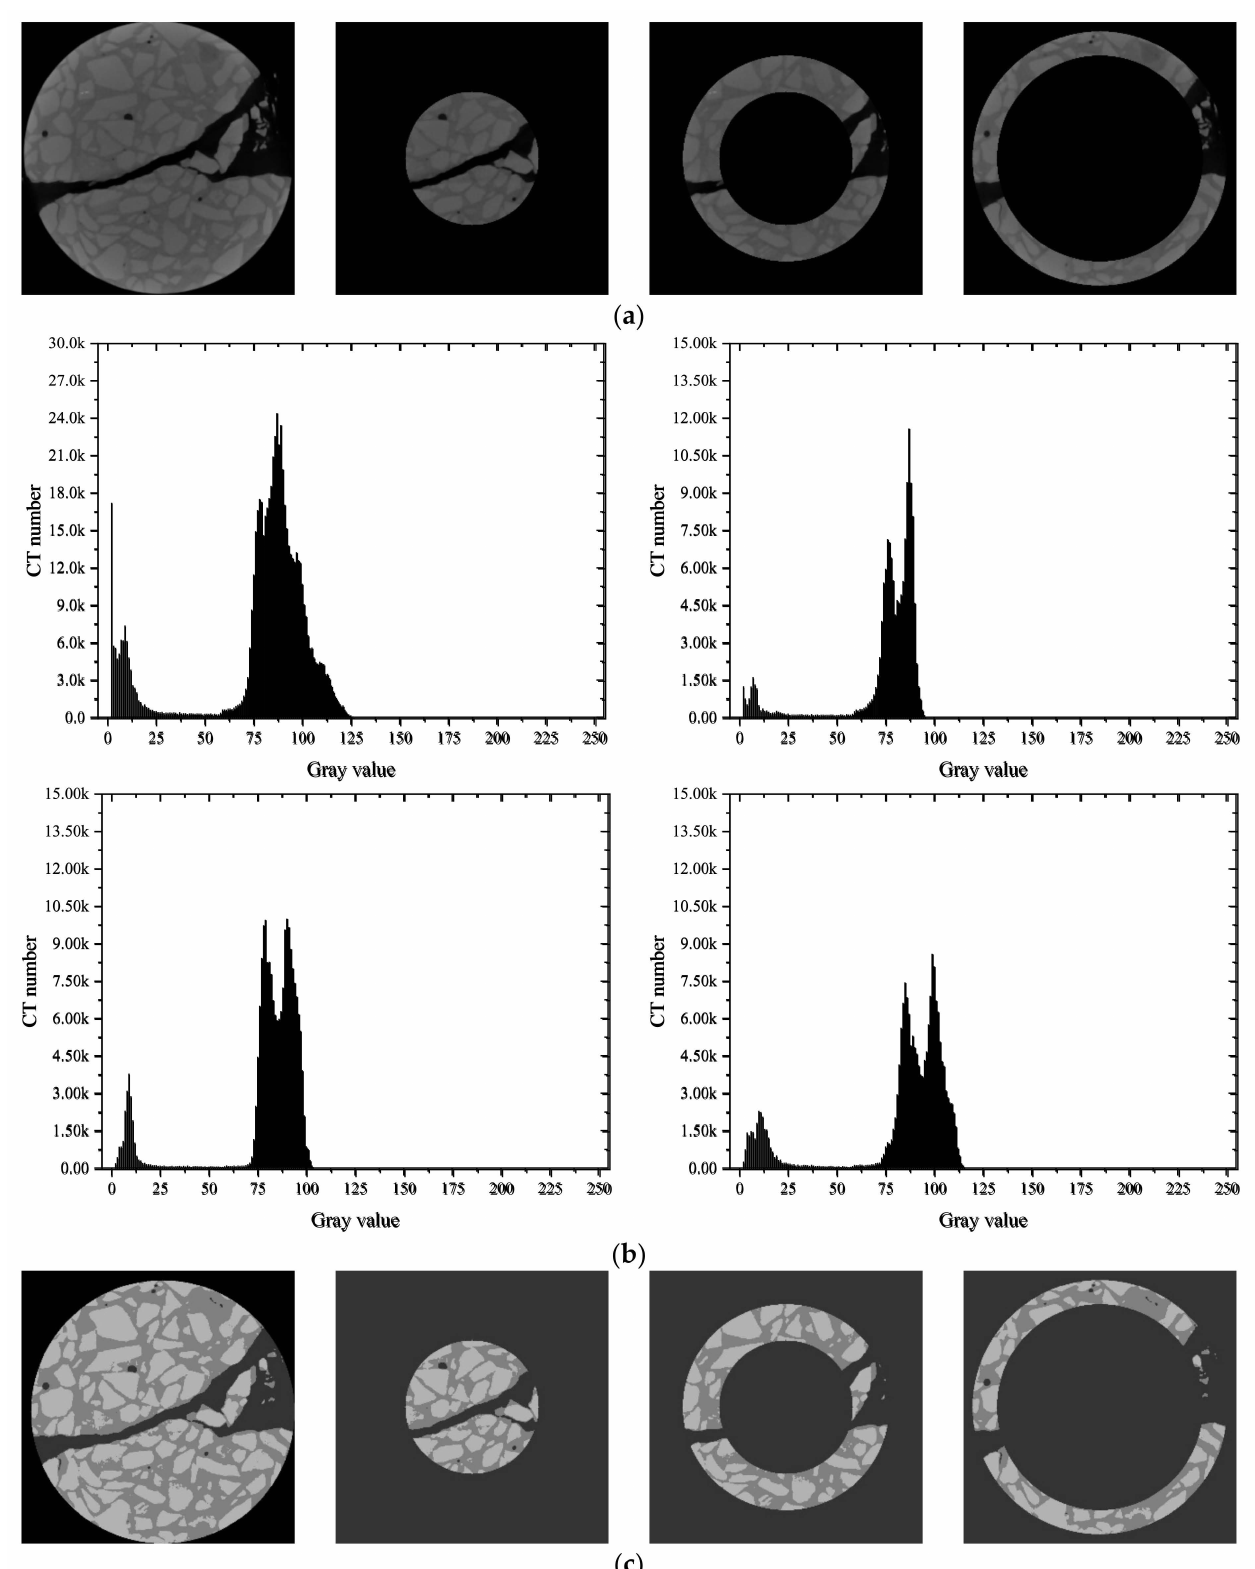
Figure 14. Block multi-threshold segmentation method: ( a ) original image and block processed images; ( b ) CT histograms of original images and segmented images; ( c ) segmented block image after multi-threshold